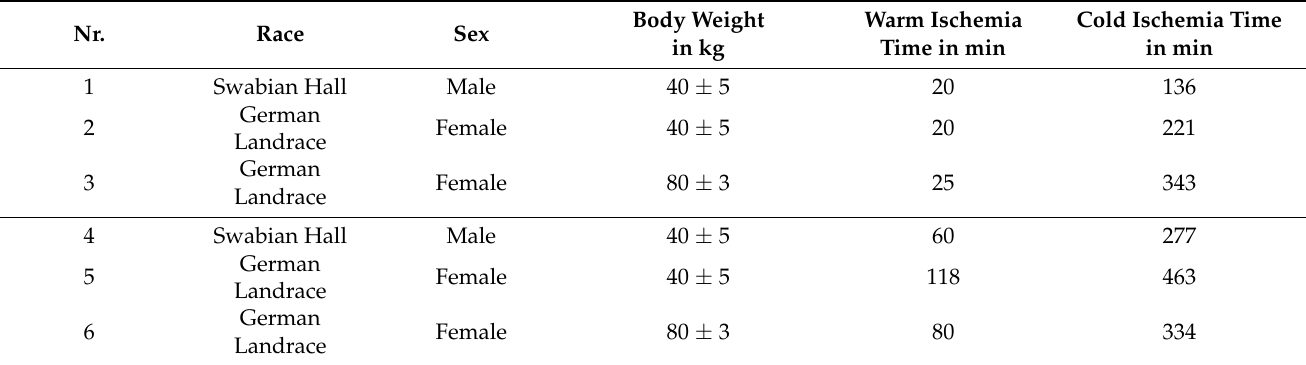
Table 4. Overview of pig characteristics. Listed are the race, sex, body weight, and ischemia time of the pigs whose kidneys are used for the spectra